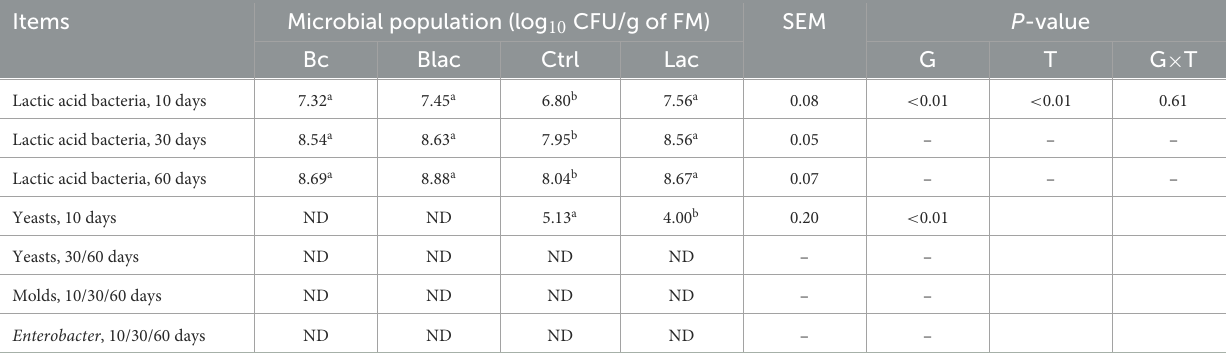
TABLE 2 Microbial population after 10, 30, and 60 days ensiling. Items